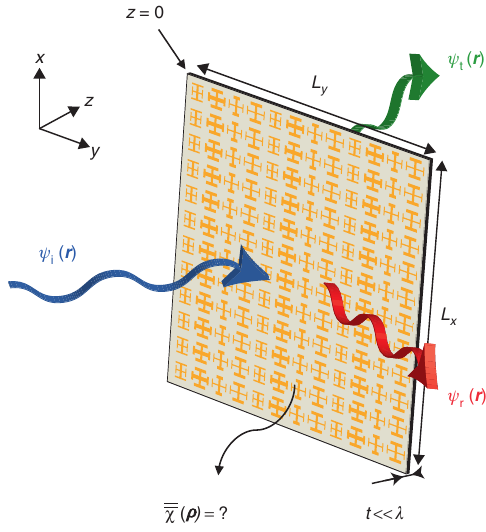
Figure 2: Metasurface synthesis problem.